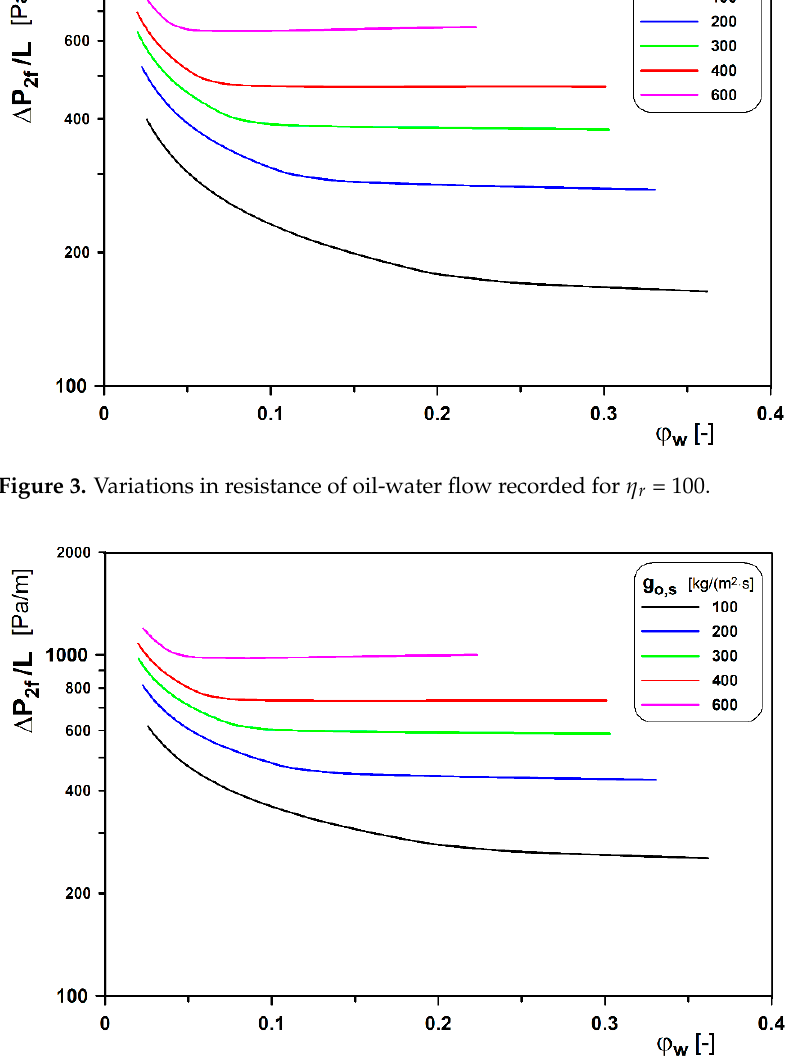
Figure 4. Variations in flow resistance for water–oil mixture recorded for η r =300.